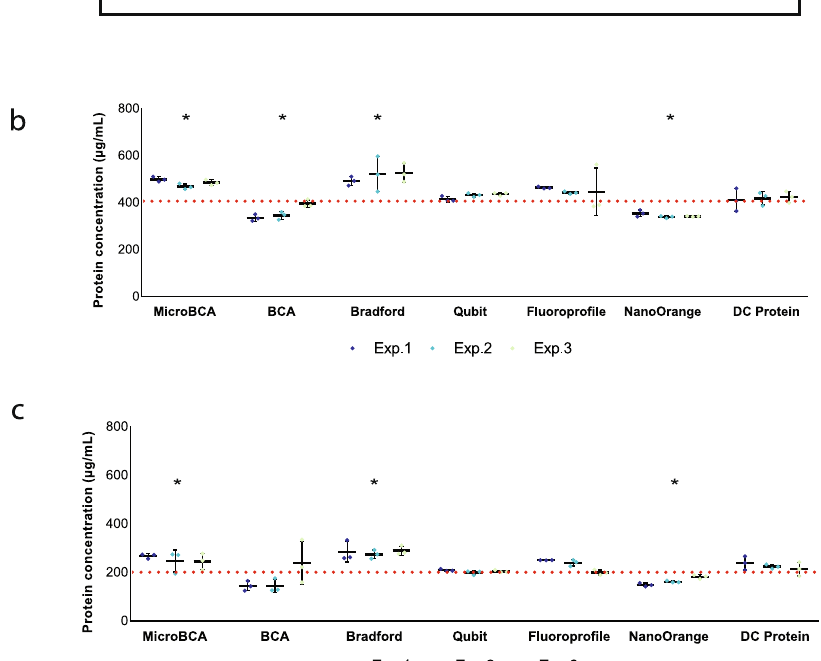
pelleting for 3 hours (Fig. 6a). Optiprep quantification in SEC fractions using the DC Protein assay was per- formed and indicated that Optiprep elution starts from SEC fraction 8–9 onwards (Fig. 6b). The majority of EVs from EV-containing Optiprep density fractions prepared from cell culture supernatant elute in SEC fractions 4–7 (Fig. 6b). Western blot immunostaining for GFP and CD9 quantification using an ELISA assay confirmed that the particles eluted in SEC fractions 4–7 were CD9 and GFP positive (Fig. 6c).